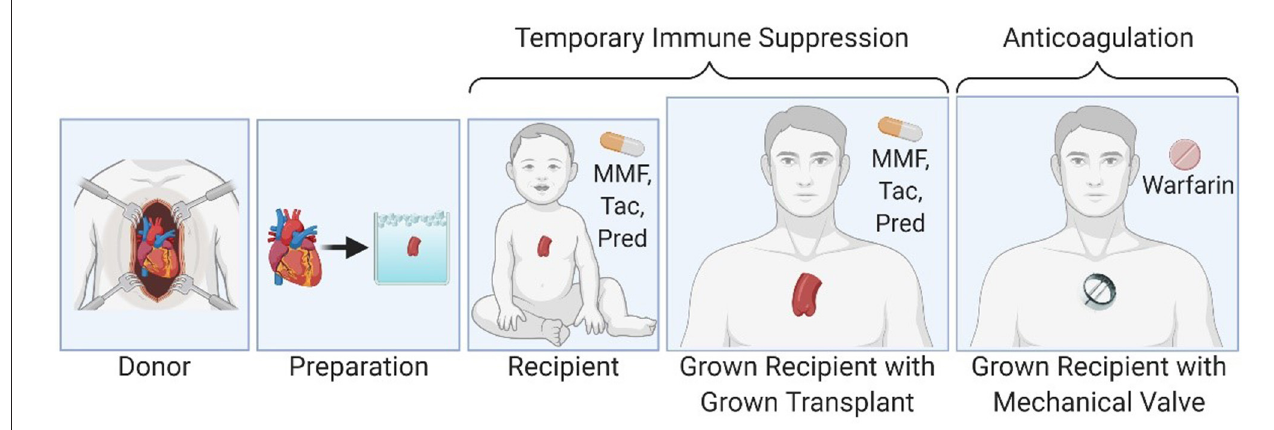
FIGURE 1 | Partial heart transplantation involves transplantation of a heart valve and temporary immune suppression until the transplanted valve can be exchanged for an adult-sized prosthetic valve in the grown